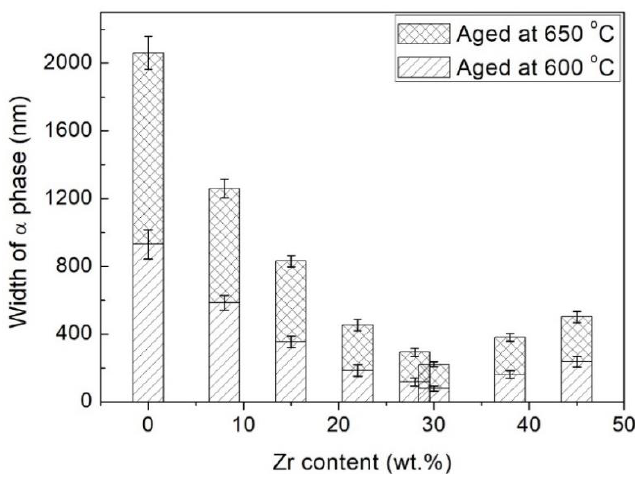
Figure 7. Width of α phase as function of Zr content after aging at 600 °C and 650 °C.